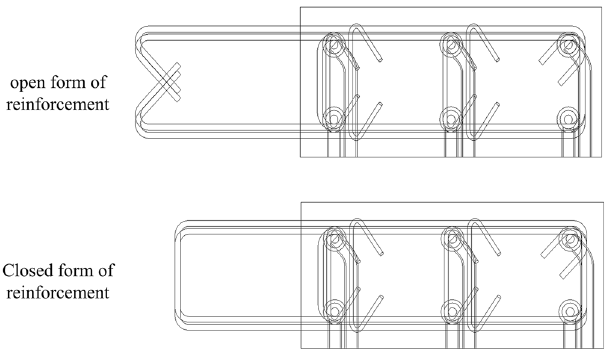
Figure 6. Reinforcement forms of edge